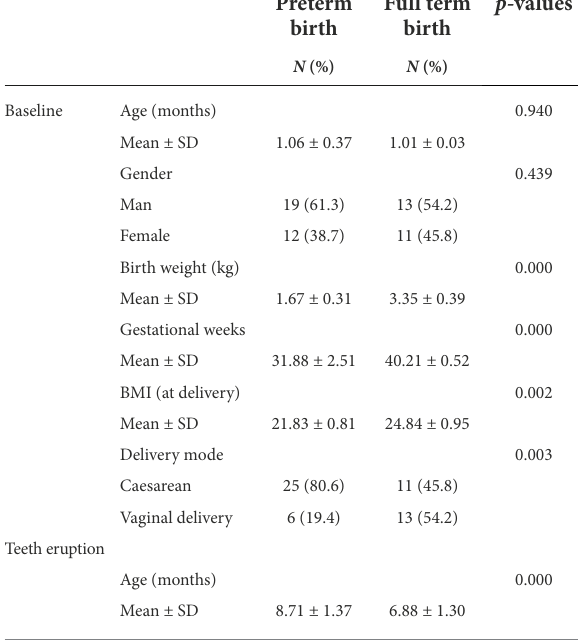
TABLE 1 Demographic characteristics of the